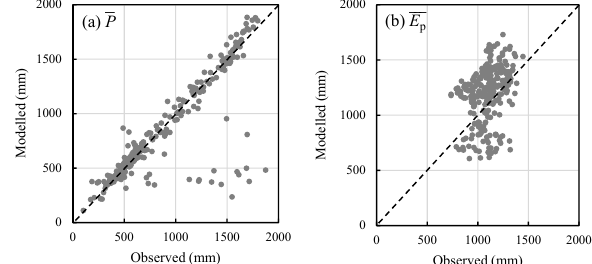
Figure 15. Comparison of the observed meteorological data with the simulations from the GFDL-ESM2M model for the pe- riod 1956–2000. (a) Mean annual precipitation P and (b) mean an- nual potential evapotranspiration E p